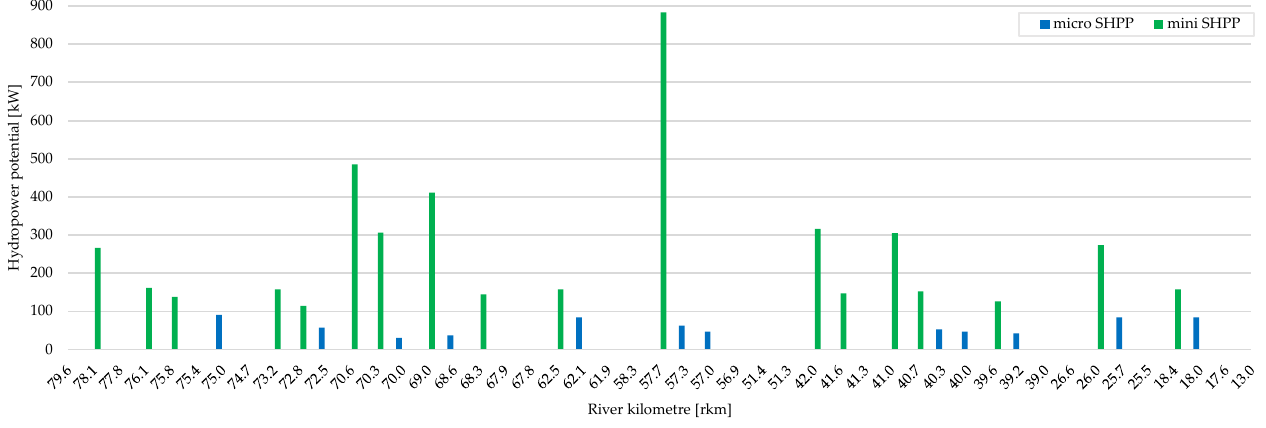
Figure 7. Technical hydropower potential of the Torysa river.